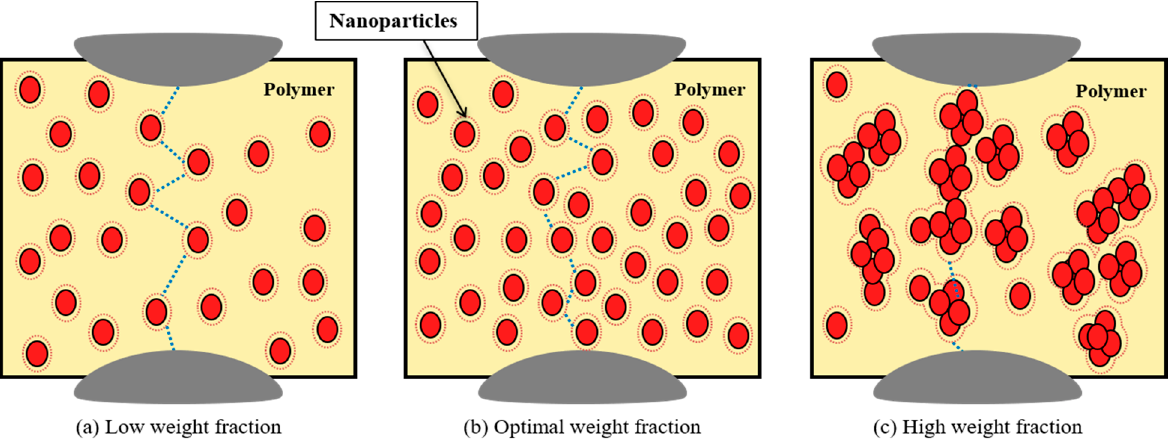
Figure 7. Effect of distribution and agglomeration of nanoparticles on breakdown strength in polymer nanocomposites; ( a ) low weight fraction, ( b ) optimal weight fraction, and ( c ) high weight fraction.